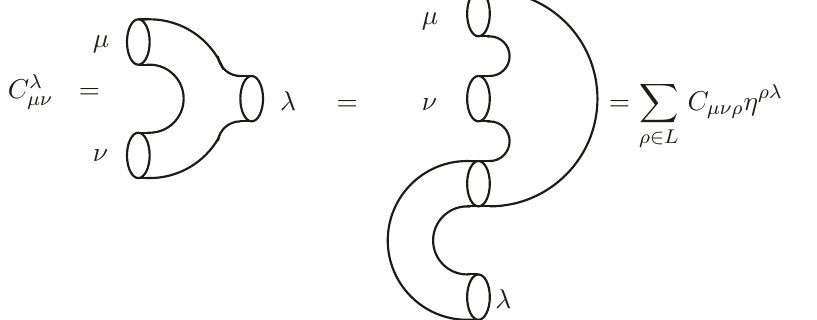
Figure 2 . The contraction of indices corresponds to gluing holes on Riemann